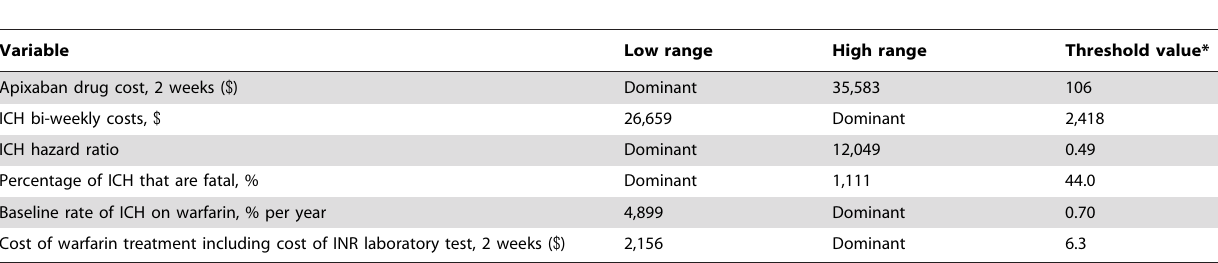
Table 2. Results of one-way sensitivity analyses comparing apixaban to adjusted-dose warfarin: parameters for which variations result in positive incremental cost-effectiveness ratios.